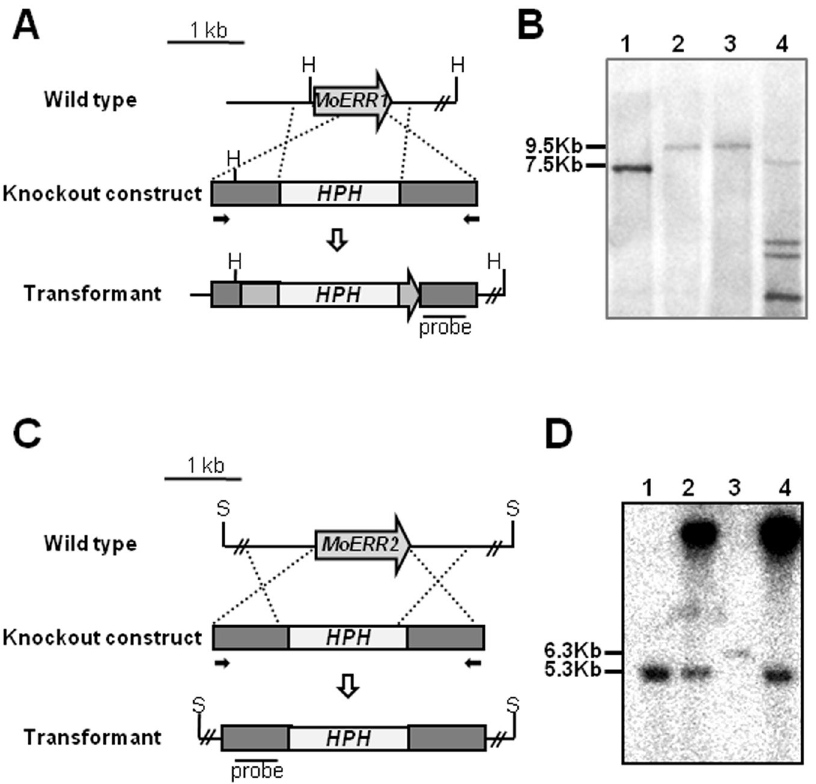
Figure 2. Targeted gene disruption of MoERR1 and MoERR2 . ( A ) MoERR1 gene disruption strategy. Moerr1 T- DNA was generated by targeted same allele of knock-out construct obtained from MoERR1 T-DNA . ( B ) Southern hybridization of MoERR1 mutants. Genomic DNA was digested by Hin dIII, and probed by 3 ′ flanking 1 kb fragment. Lane 1: wild type strain KJ201; Lane 2: MoERR1 T-DNA ; Lane 3: Moerr1 T-DNA ; Lane 4: E1-46 (ectopic transformant). Blot image were cropped for better display. ( C ) MoERR2 gene deletion strategy using double- joint PCR. Knockout construct was designed to include upstream ~1 kb fragment and downstream ~1 kb fragment of MoERR2 ORF linked with HPH cassette. ( D ) Southern hybridization of MoERR2 mutants. Genomic DNA was digested by Sal I, and probed by 5 ′ flanking 1 kb fragment. Lane 1: wild type strain KJ201; Lane 2: E1-3 (ectopic transformant); Lane 3: ∆ Moerr2 ; Lane 4: E1-46 (ectopic transformant). Blot image was cropped for better